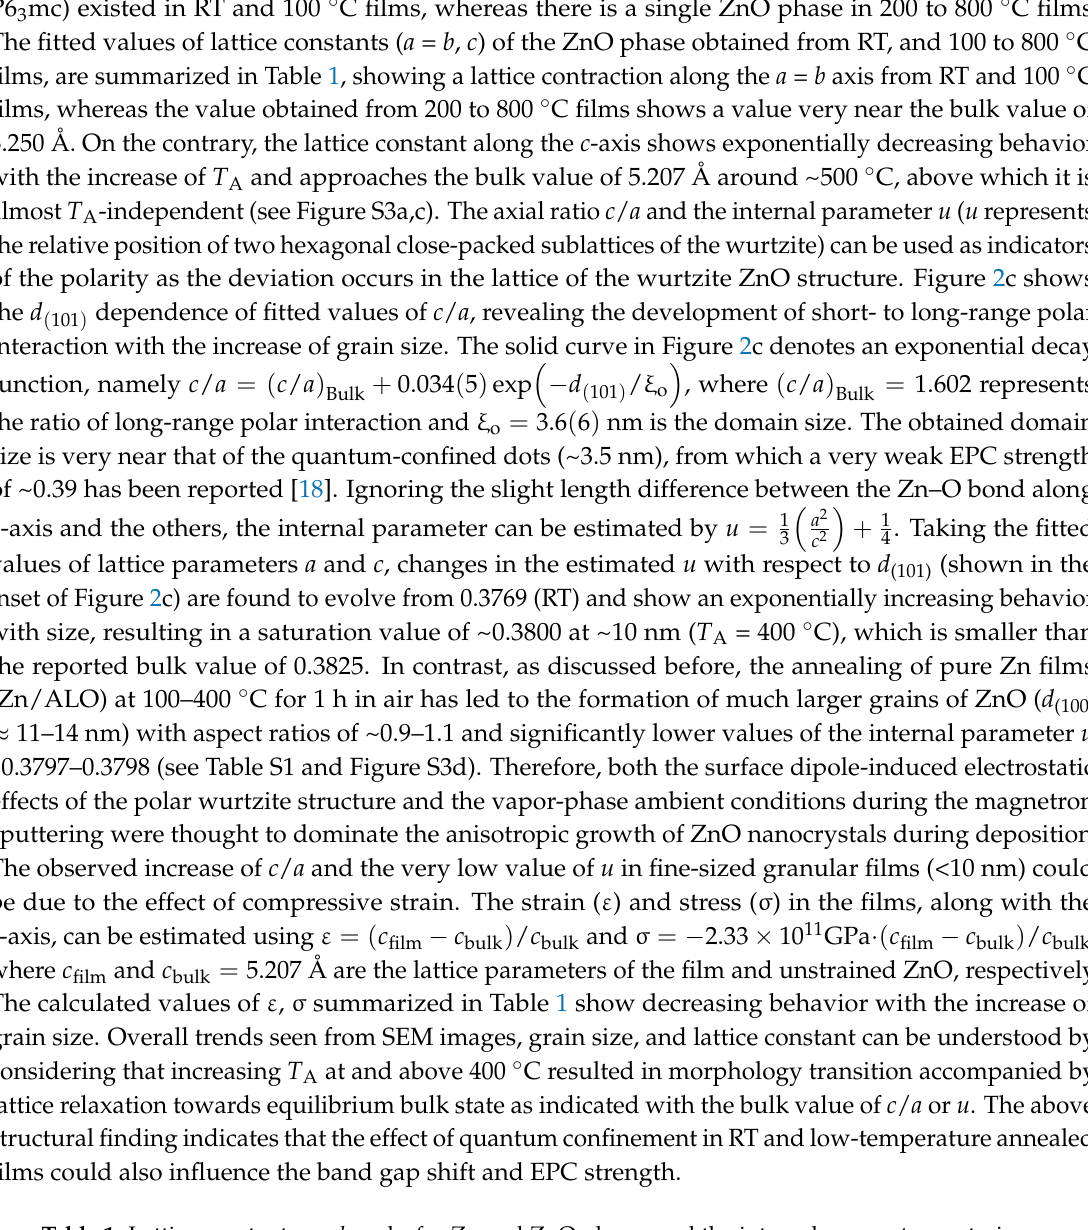
Table 1. Lattice constants a = b and c for Zn and ZnO phases and the internal parameter u , strain ε , stress σ , and parameters wRp and Rp for fitting the XRD patterns of the ZnO/ALO films based on the “F(calc) weighted” LaBail extraction analysis